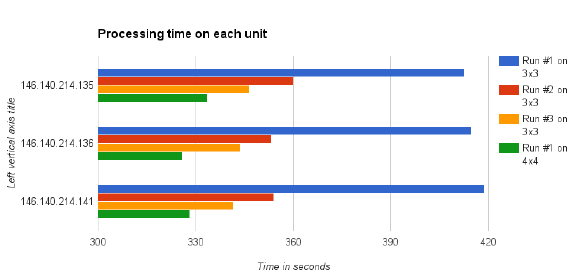
Figure 6: Processing time reduces inversely proportional as the size of grids increases